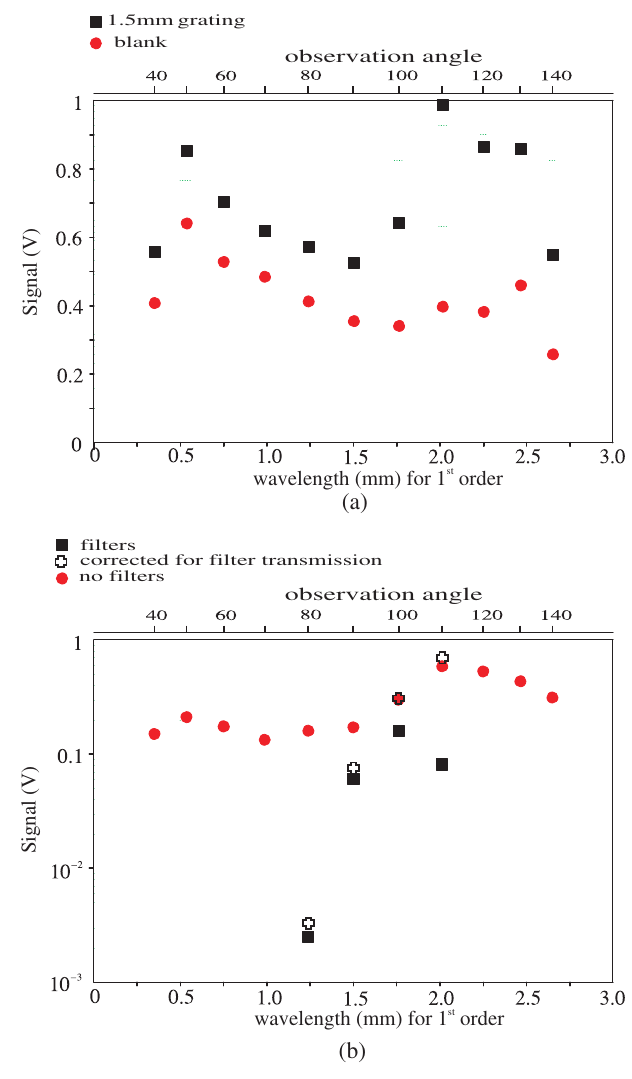
FIG. 6. (Color) (a) Signals from the 1.5 mm grating (squares) and from the blank (circles), obtained without the use of filters and (b) the net signal without the use of filters (circles) and with filters (squares). The open crosses represent the signal level when the filter transmission efficiency has been taken into account. See text for